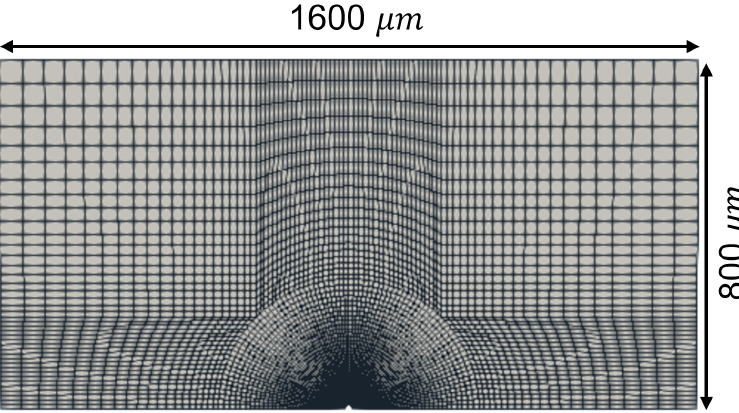
Figure 5. Computational domain specifications used during